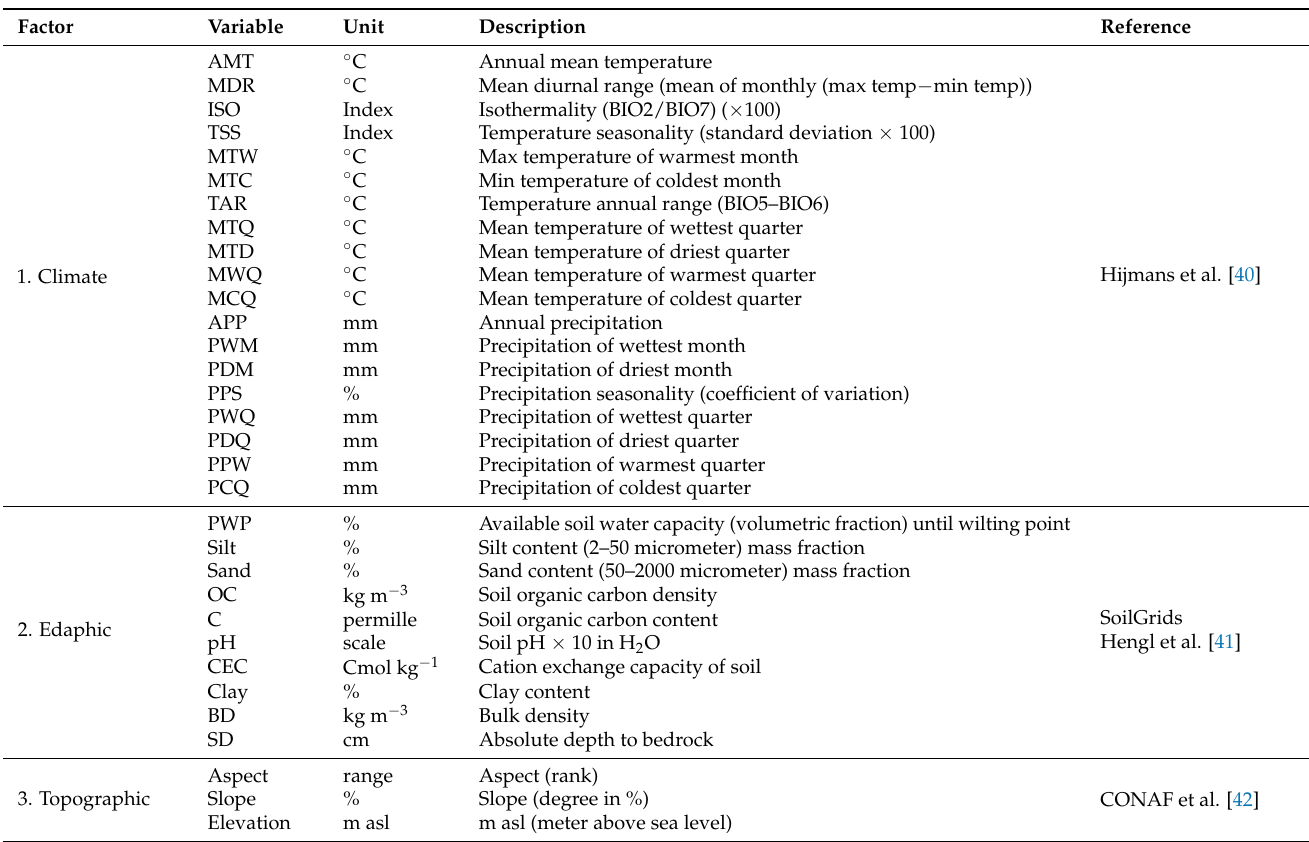
Table 1. Factors and environmental variables analyzed (soil variables estimated at a depth of 0.3 m). Factor Variable Unit